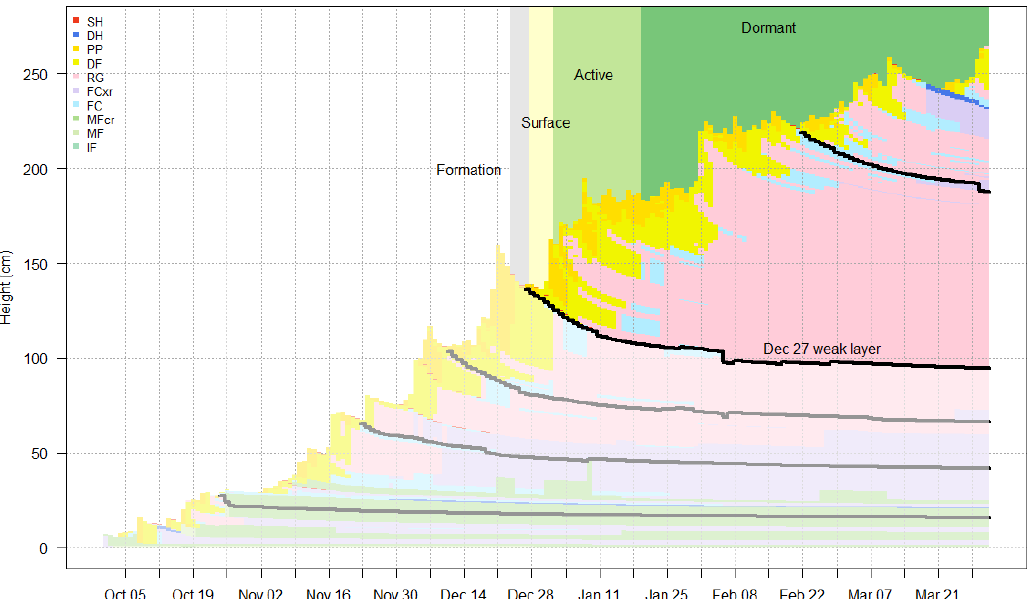
Figure 3. Weak layers identified in the 2019–2020 treeline profiles. Five weak layers were listed in the hazard assessments, and the heights of modelled layers most likely associated with these weak layers are shown with black and grey lines. The status of the 27 December weak layer over time is highlighted. The layer was attributed to a persistent-slab avalanche problem between 2 and 19 January and thus assigned the status active. The layer was assigned the status surface prior to this period and dormant after this